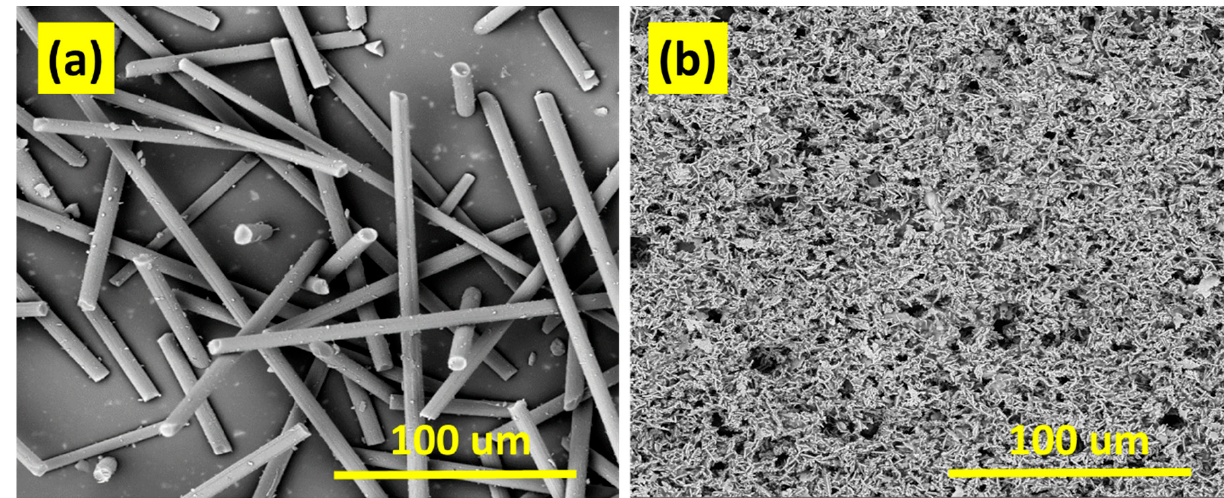
Figure 7. SEM micrographs of carbon fibers/particles, ( a ) Before milling ( b ) After